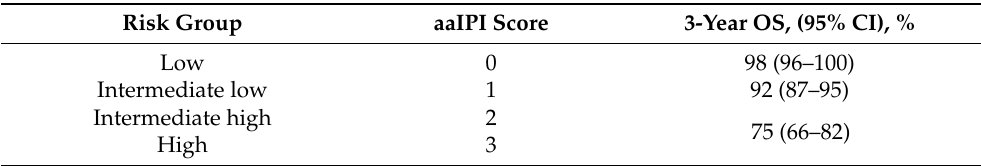
Table 3. Age-adjusted International Prognostic Index (aaIPI). 1 score for each: Stage III–IV, elevated Lactate Dehydrogenase, ECOG performance status